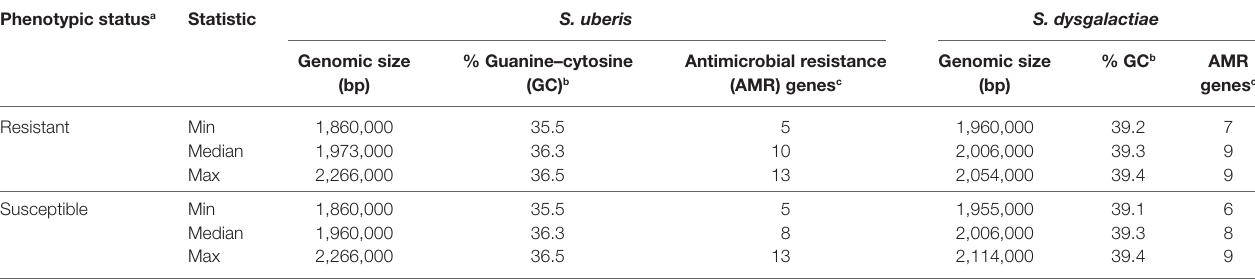
TaBle 1 | summary of the genomic characteristics of Streptococcus uberis ( n = 56) and Streptococcus dysgalactiae ( n = 17) isolates by phenotypic antimicrobial susceptibility status. Phenotypic status